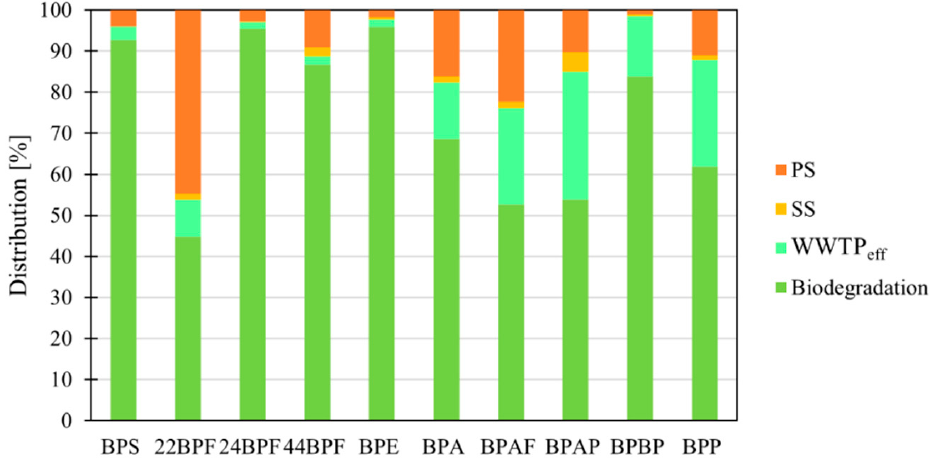
Figure 7. Distribution of BPs in primary and secondary sludge, WWTPeff and their biodegradation.